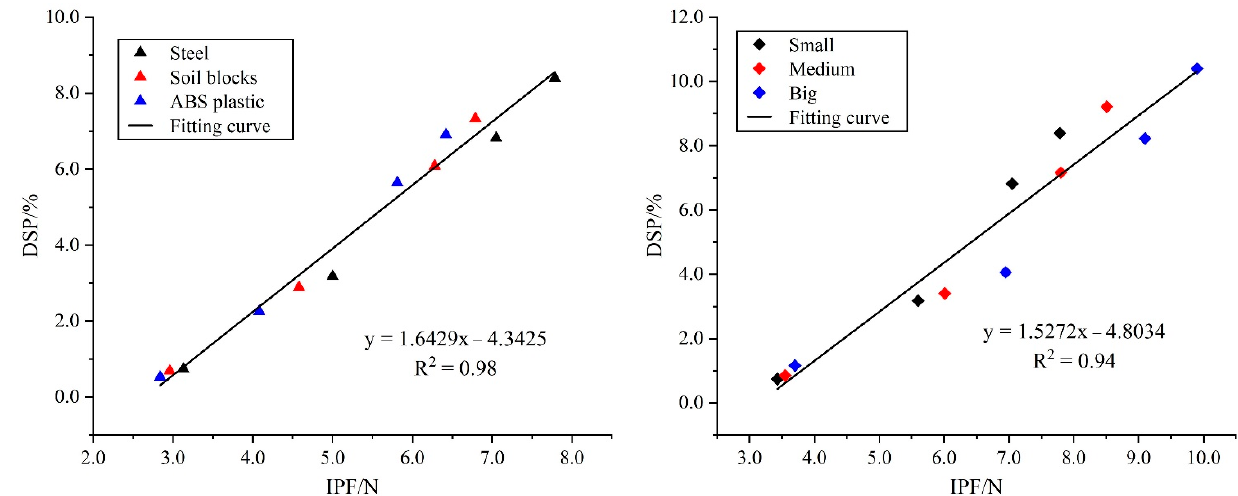
Figure 11. IPF and DSP relationship for different materials and seedling pot